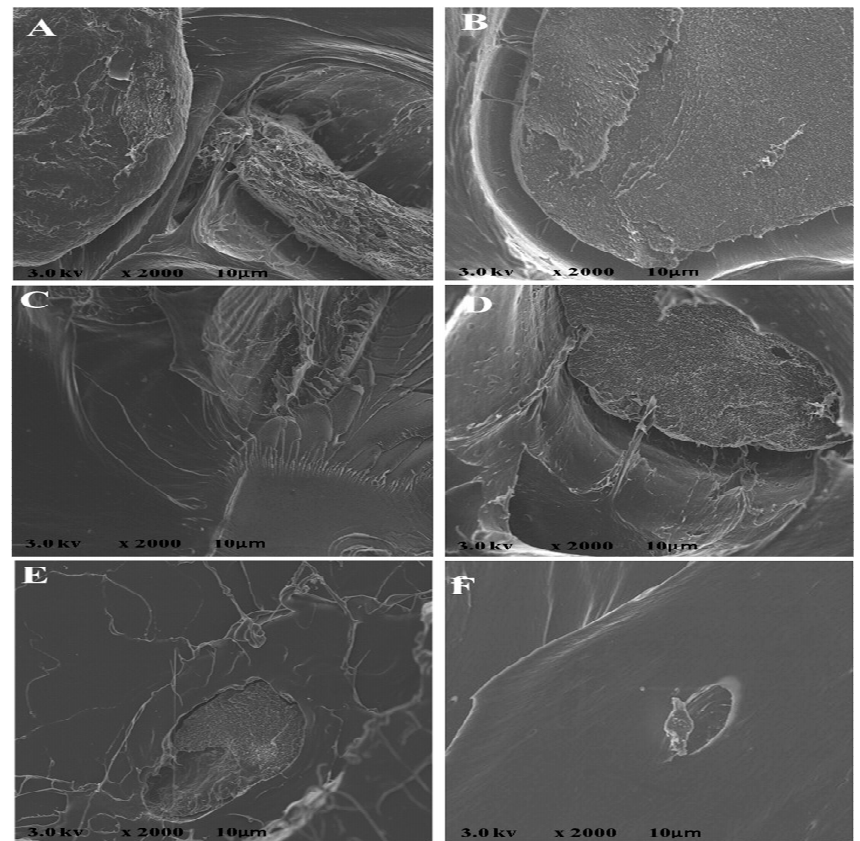
Figure 3. Scanning electron microscope images for samples with the ratios A—92% polylactic acid (P) / 8% chitin (C); B—92% P / 6% C / 2% starch (S); C— 92% P / 4% C / 4% S; D—92% P / 2% C / 6% S; E—92% P / 8% S; F—100% P.